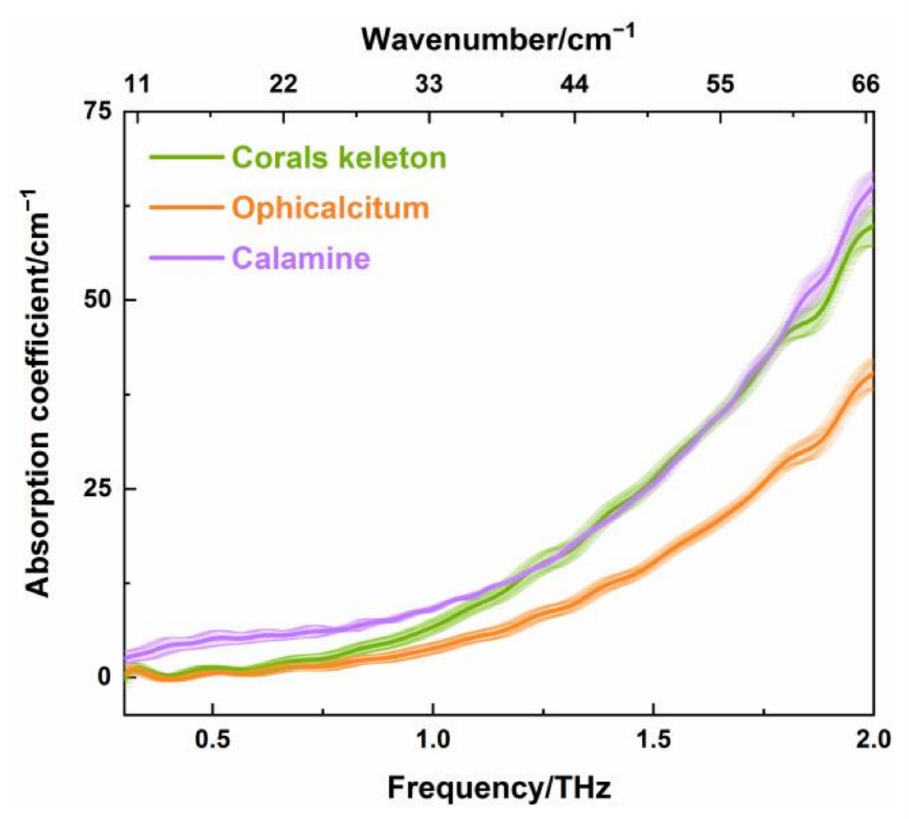
Figure 3. THz absorption spectra of coral skeleton, ophicalcitum, and